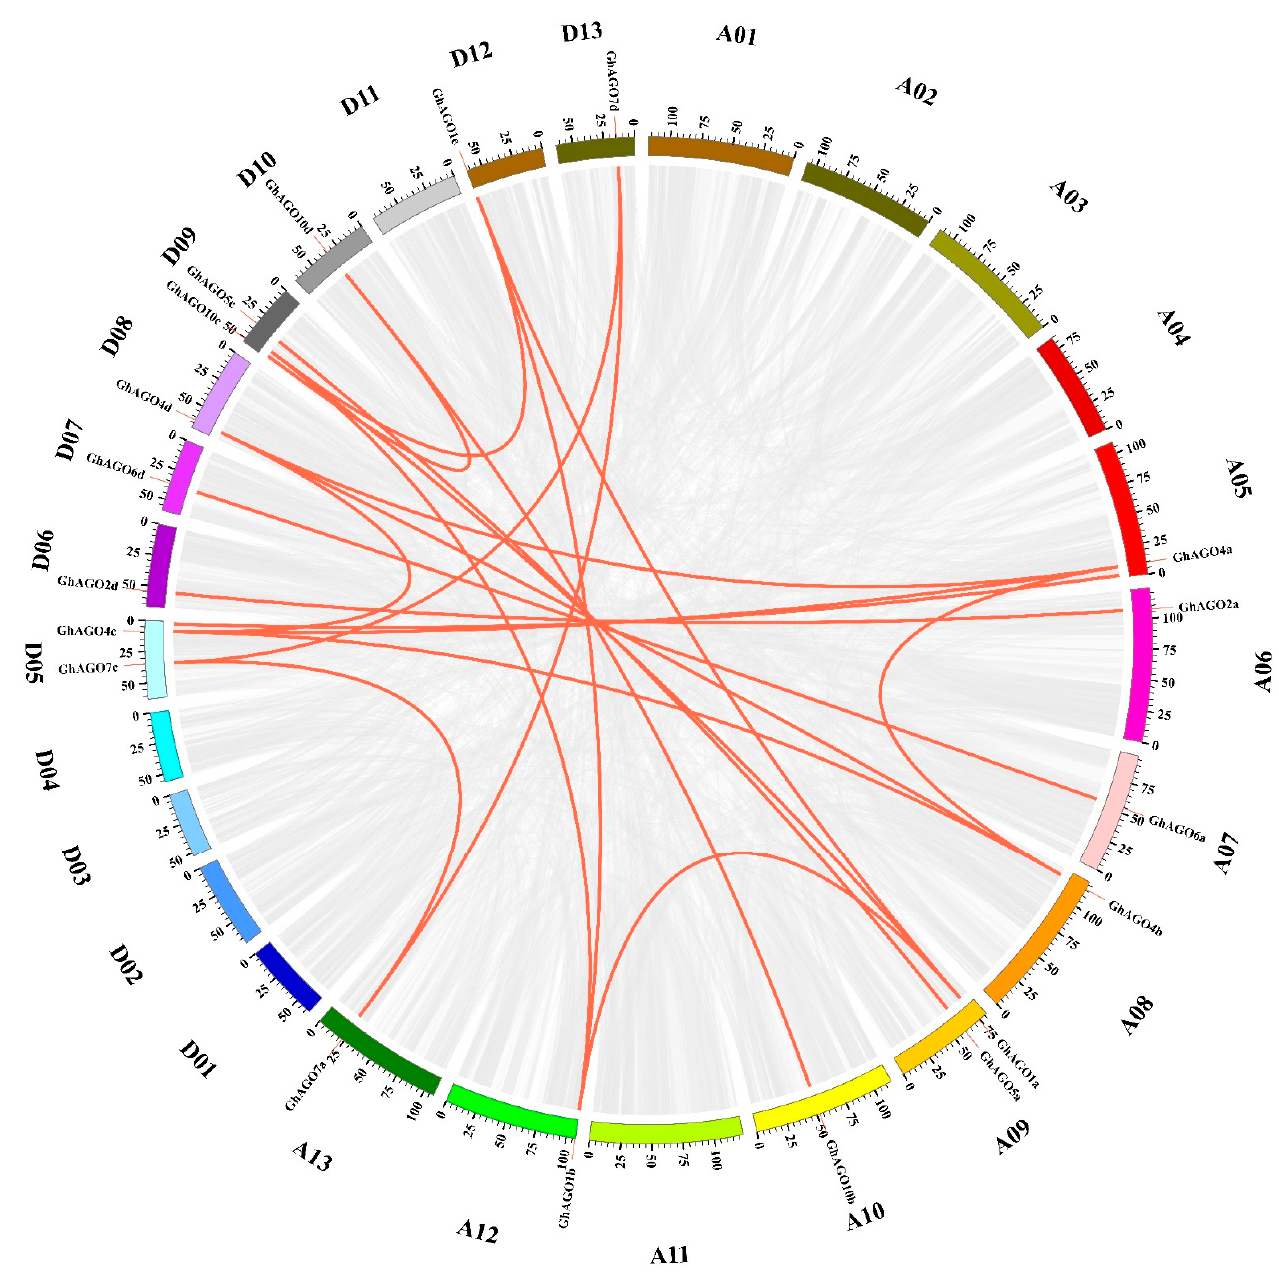
Figure 3. Collinearity analysis of GhAGO genes in G. hirsutum . The red lines highlight the 22 pairs of segmental duplications. The scale bar marked on the chromosome indicates chromosome lengths (Mb).